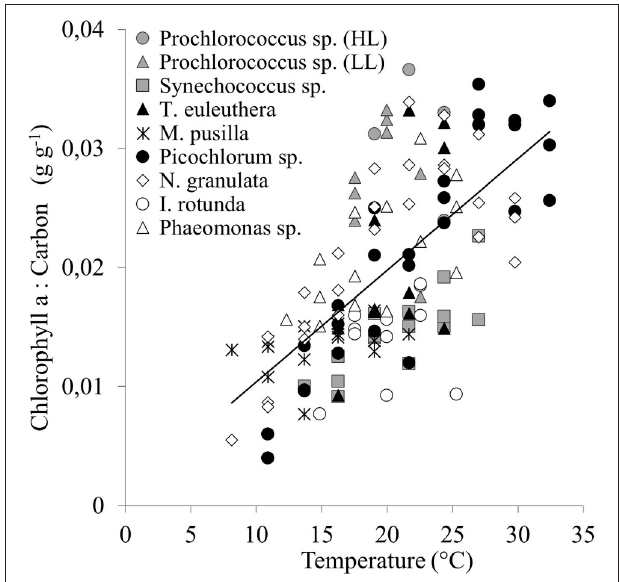
FIGURE 5 | The response of the chlorophyll a to carbon ratios of a group of picophytoplankton to temperature. The line indicates a linear regression including data for all 9 species (Equation 9, r 2 = 0.42, p <